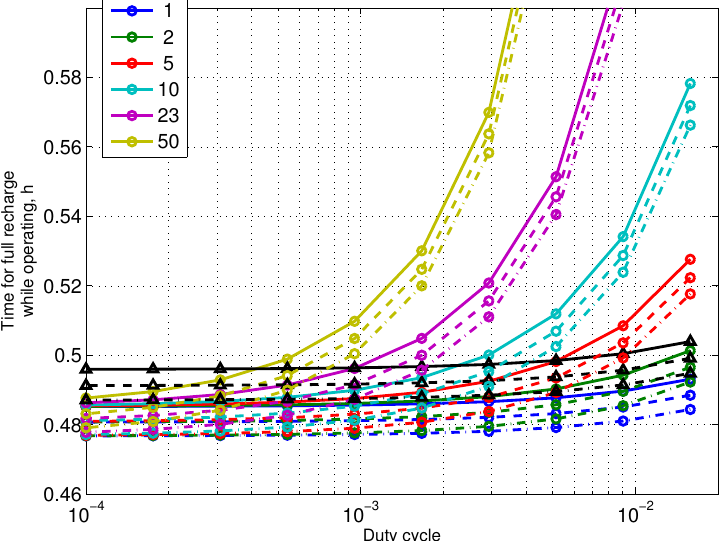
Figure 13. Detailed figure when M t = 1 and M r = 1, time for full recharge while operating with capacitor ( C s = 0.35 F). Non-WuR in black (without triangles), passive WuR in colors indicating number of nodes for different host duty cycles per node ( β (cid:48) w ). Semi-passive WuR in black with triangles. Line type indicates used SC leakage current model as —: upper , - - -: median, and -.-.-: